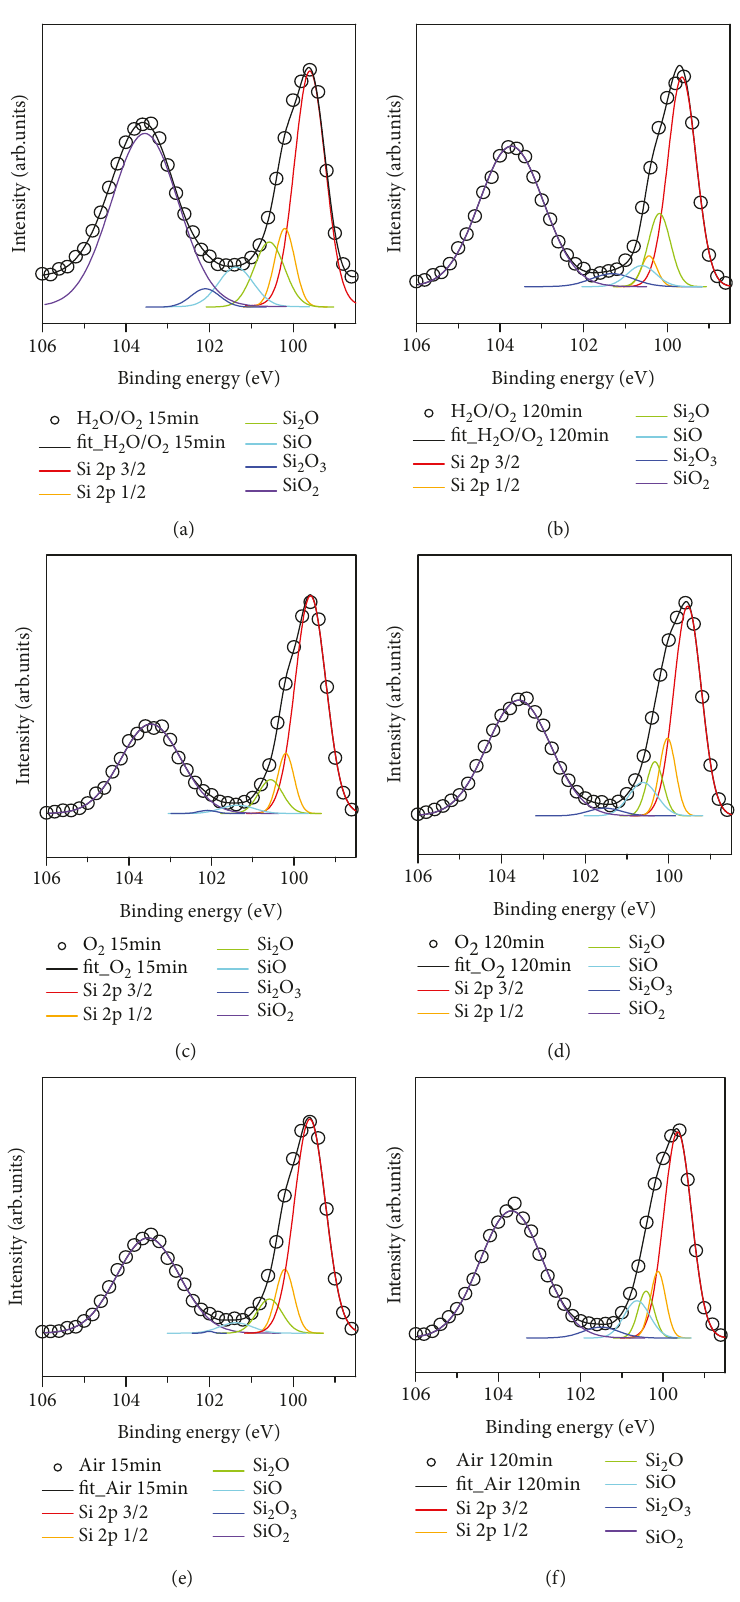
fi lms formed in ambient (a) H x